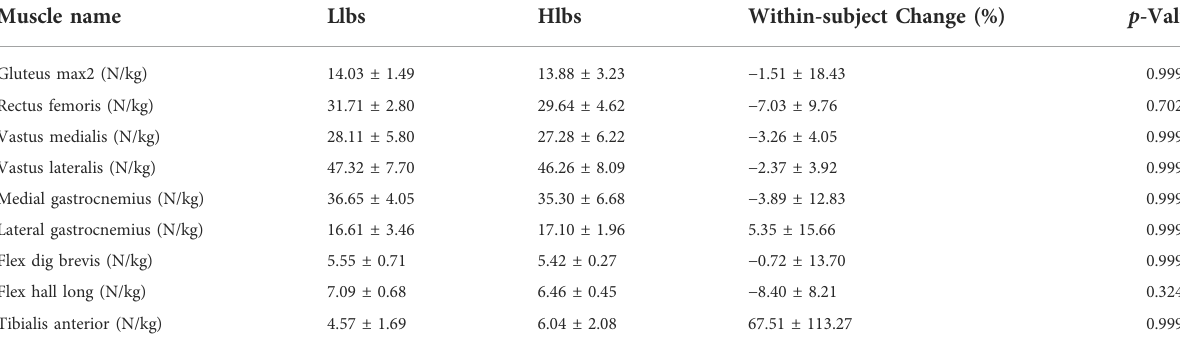
TABLE 3 Peak muscle force during stance phase in the Llbs and the Hlbs shoes (mean ±